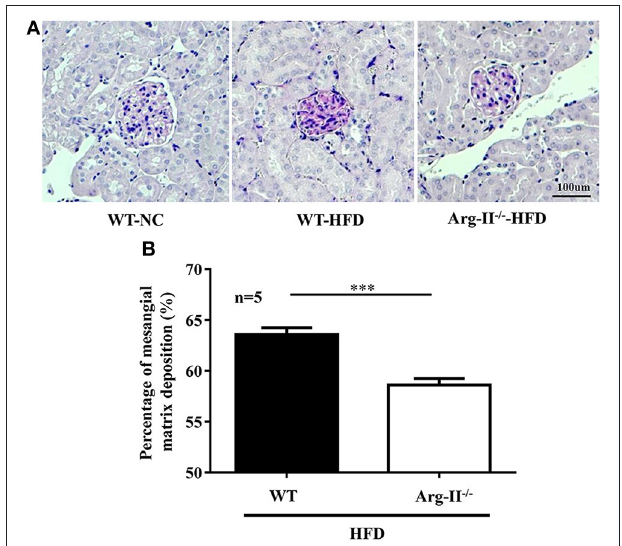
FIGURE 7 | Arg-II-deficiency protects against mesangial expansion in obesity. (A) PAS staining (magenta) of paraffin-embedded kidney sections shows decreased mesangial expansion in Arg-II − / − mice as compared to WT mice on HFD. Nuclei were counter stained by hematoxylin (blue). Kidney from a WT mice on NC diet was used as a control. (B) Bar graphs show quantification of mesangial expansion. n = 5, *** p < 0.001 vs. WT-HFD group.